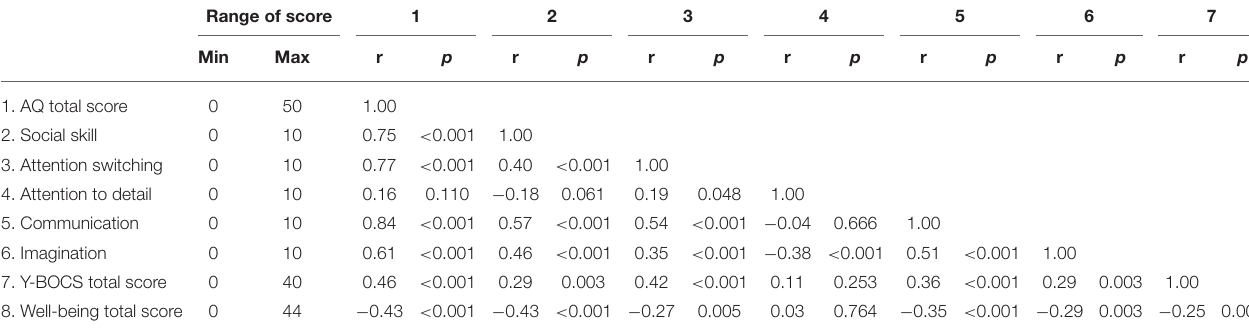
TABLE 1 | The results of Pearson’s correlation. Range of score 1